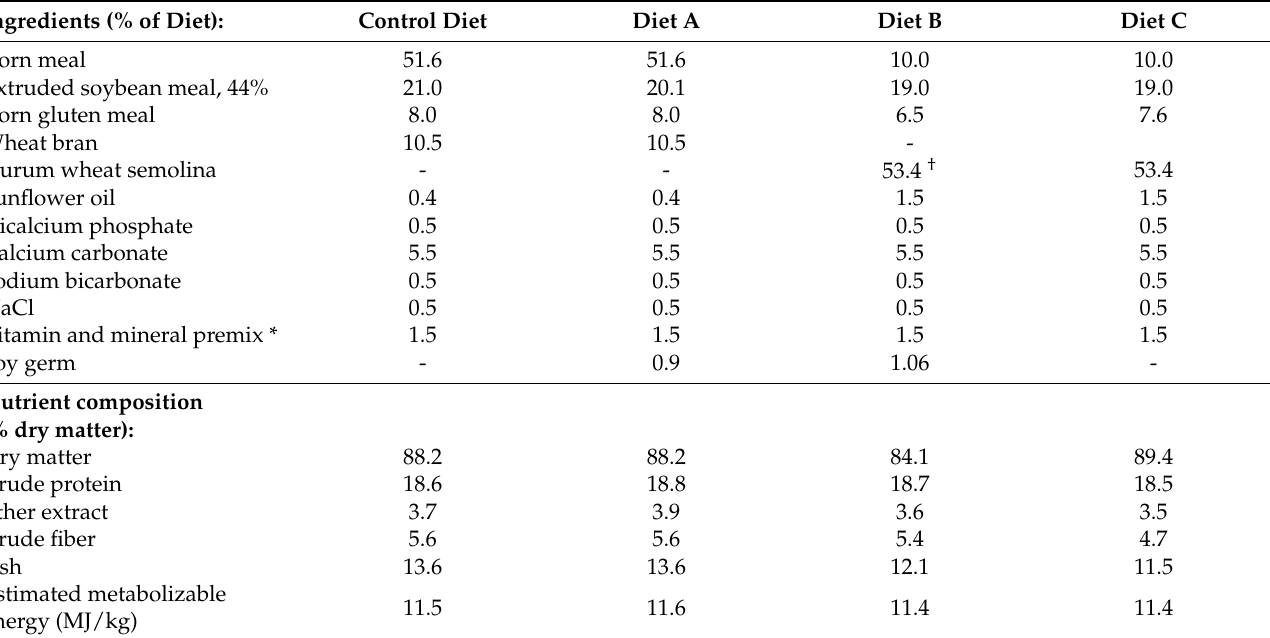
Table 1. Ingredient and nutrient composition of the Control diet, the Control diet with added soy germ providing mainly isoflavone glycosides (diet A), the Control diet with addition of ground dried soy germ pasta with predominantly isoflavone aglycons (diet B), and the Control diet with addition of conventional pasta lacking isoflavones (diet